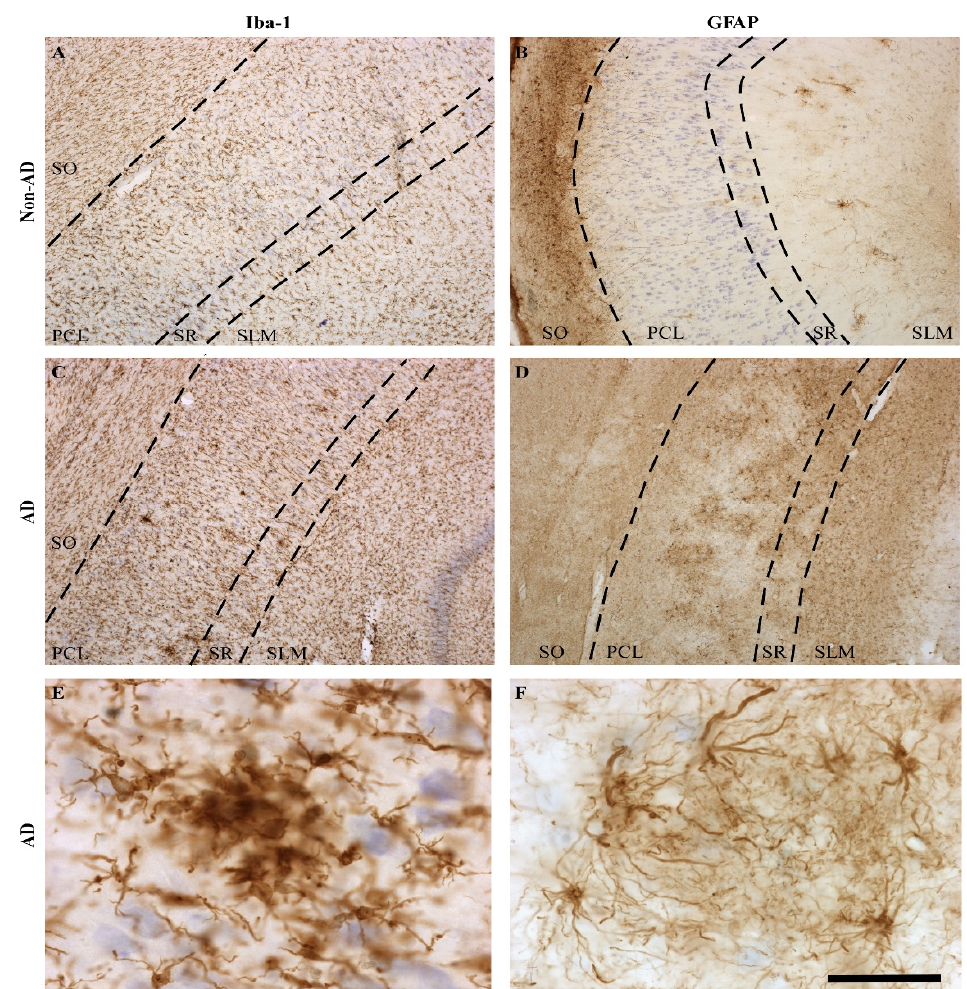
Figure 3. Glial distribution pattern changes in the CA1 region in AD samples. Staining of microglial cells ( A ) revealed homogeneous distribution throughout the different layers in non-AD samples ( A ).